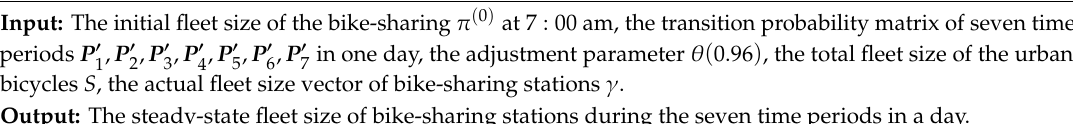
Algorithm 1: Markov chain dockless bike-sharing fleet size